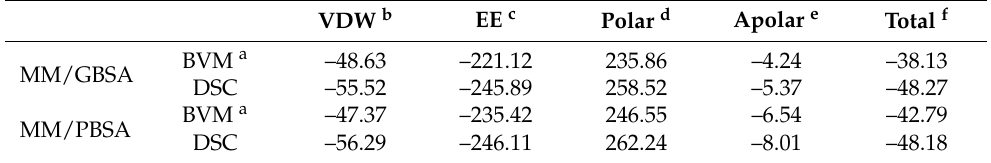
Figure 7. Visualization of interactions between CA-SP1 and DSC. Table 3. Binding free energies (kcal/mol) of DSC and BVM by the MM/GBSA and MM/PBSA methods.